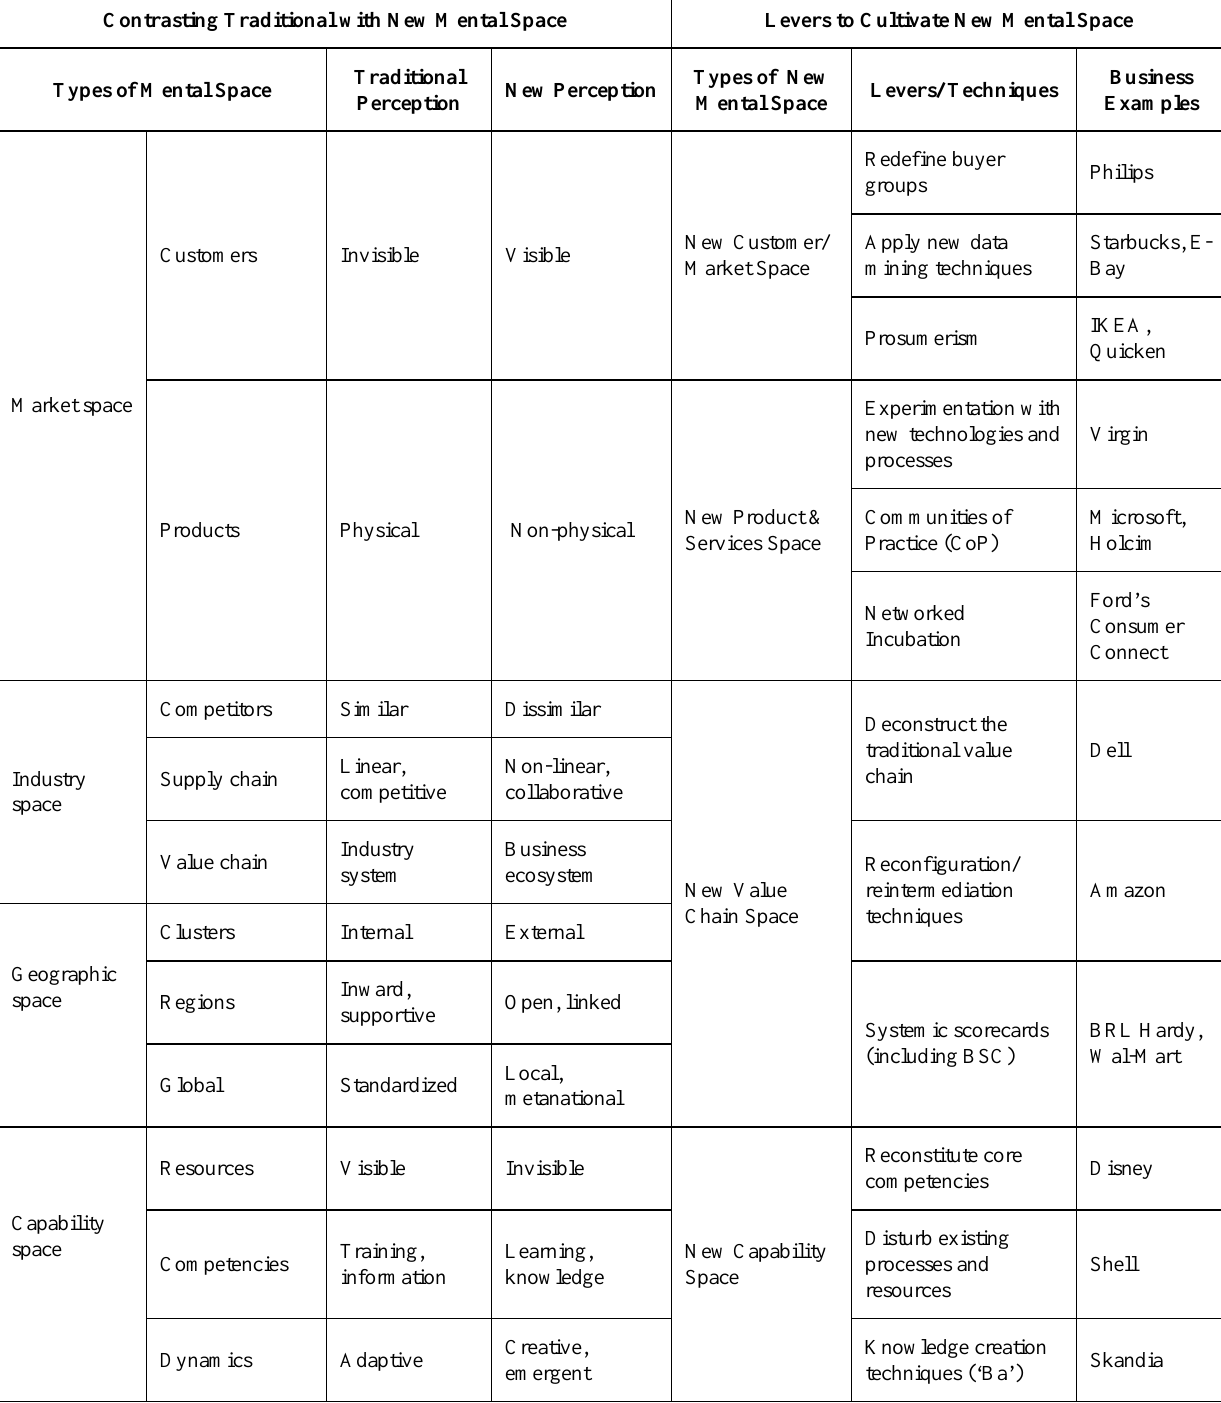
Table 2: Traditional and new types of mental space, and levers to cultivate new mental space Contrasting Traditional with New Mental Space Levers to Cultivate New Mental Space Types of Mental